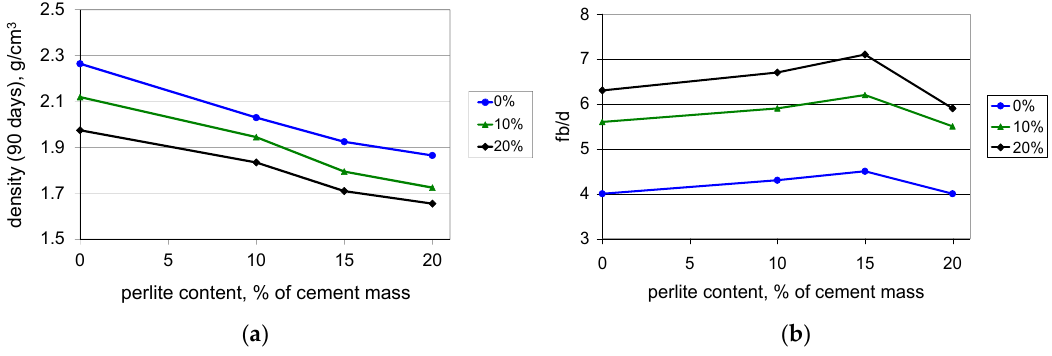
Figure 7. Density ( a ) and flexural strength to density ratio ( b ) of the mortars with polymer content values of 0%, 10%, and 20% of cement mass vs. waste perlite content after 90 days of curing.